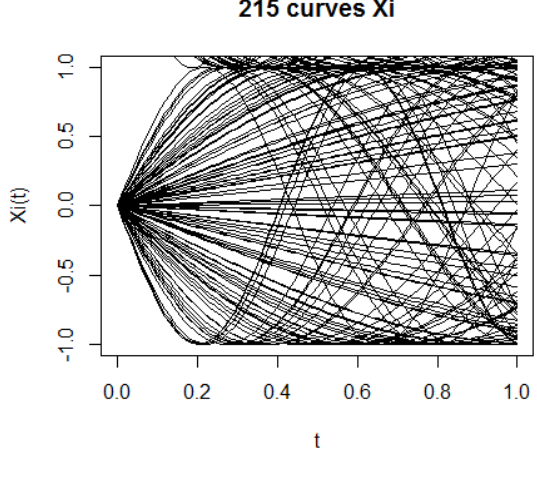
Figure 1: A sample of curves { X i ( t ) , t ∈ [0, 1] }